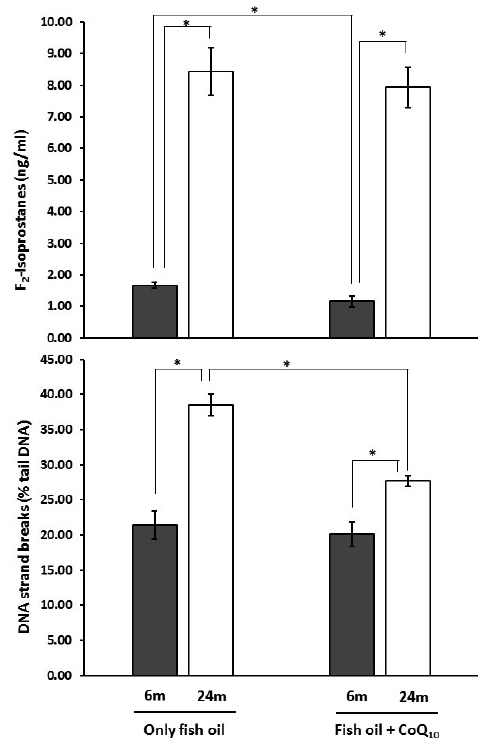
Figure 3. Effects of supplementation with coenzyme Q 10 (CoQ 10 ) on urinary levels of F 2 ‐ isprostanes and DNA strand breaks in lymphocytes in 6 ‐ and 24 ‐ month ‐ old (m) rats fed fish oil as dietary fat. Results are expressed as mean ± standard error of mean of six animals. * Statistically significant differences ( p < 0.05) determined by the Mann–Whitney U ‐ test.